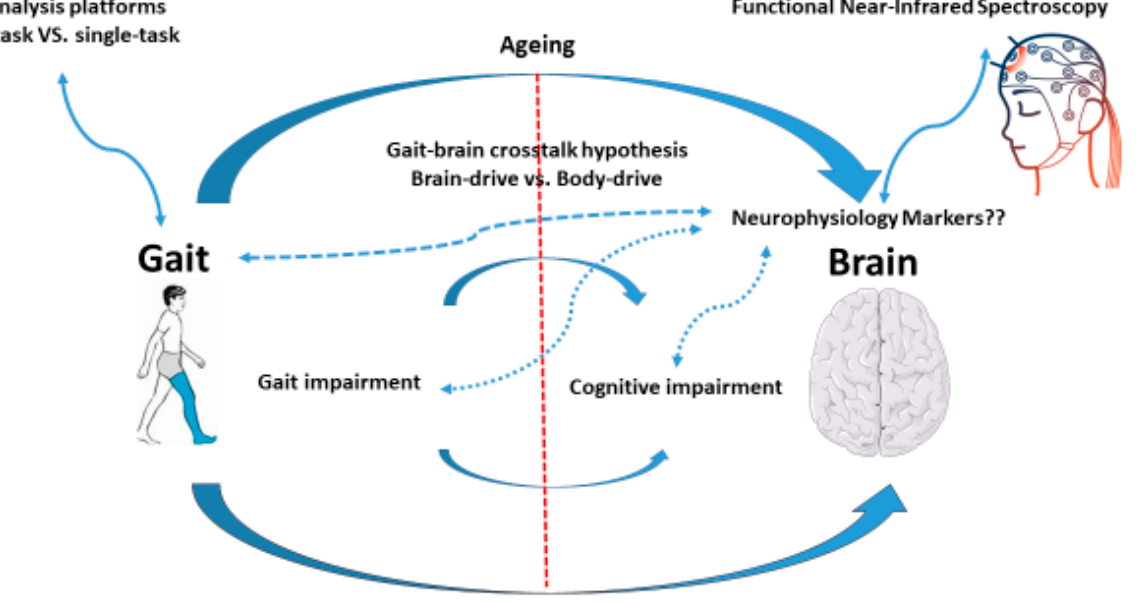
Figure 1. Model of dual gait and brain function decline. The Figure was partly generated